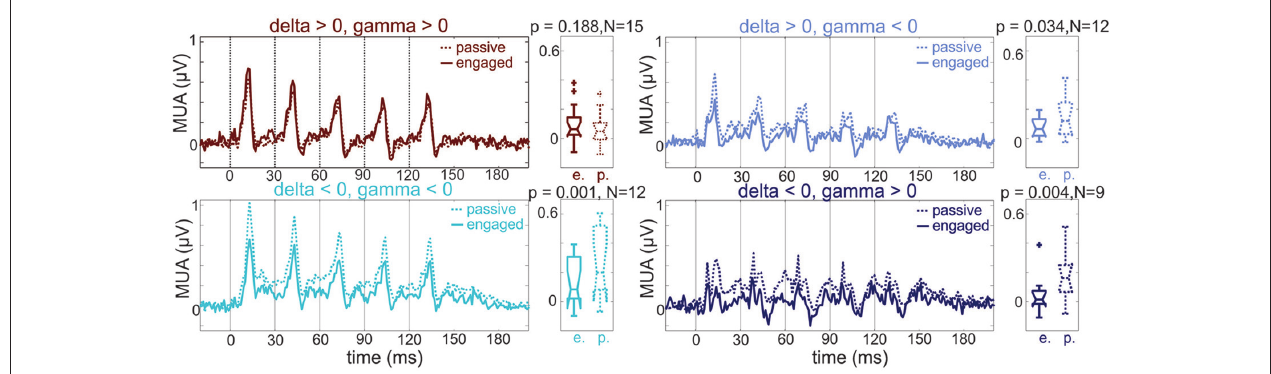
FIGURE 6 | MUA responses in A1 regions with differing pre-stimulus phases. Pooled MUA responses of sites with different pre-stimulus delta-gamma phase combinations (same groups of sites and same color coding as sites in the engaged condition of Figure 5C ). Boxplots to the right show the MUA response amplitudes across sites averaged in the 60–160 ms time interval. While the first group of sites shows no engagement related suppression, the other three groups of sites do. Note that the patterns of suppression seem to match the delta-gamma phase combinations remarkably well: while the suppression is maximal at the times of the individual click related responses in the depolarizing delta—hyperpolarizing gamma group (upper right panel, light blue), the suppression is more sustained in the groups where pre-stimulus delta is in a hyperpolarizing phase (lower panels, cyan and dark blue). Wilcoxon signed rank test, p < 0.01, N = number of A1 sites in each